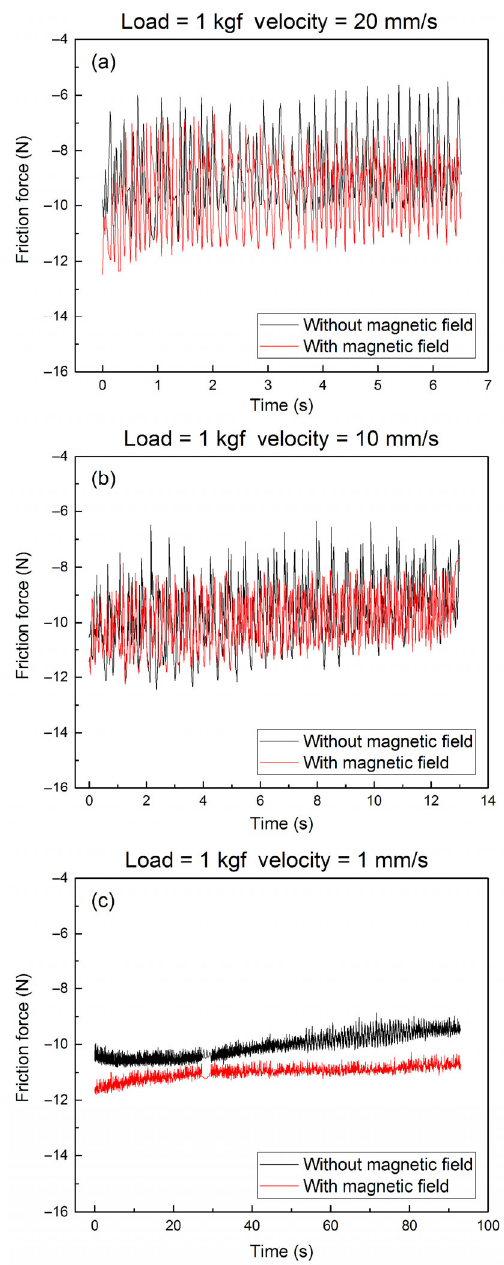
Fig. 4 Results of friction force tests under load of 1.0 kgf without and with a magnetic field: (a) velocity of 20 mm/s, (b) velocity of 10 mm/s, (c) velocity of 1